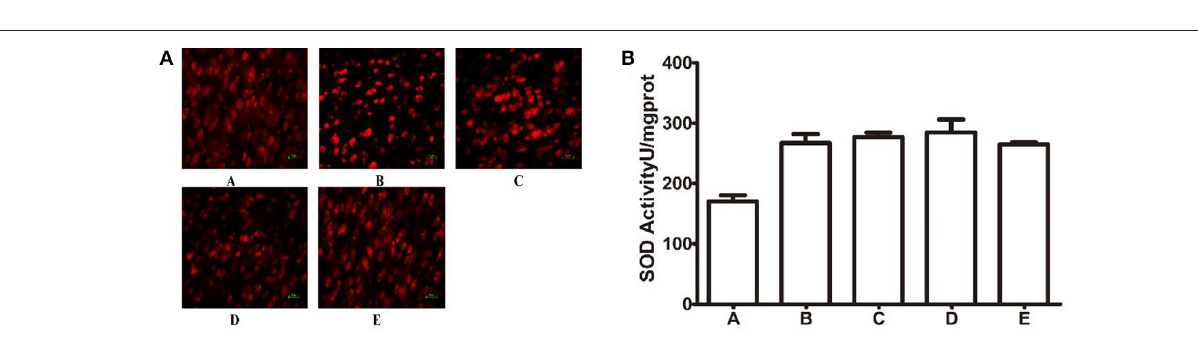
FIGURE 8 | Changes of ROS generation in different groups. (A) ROS Fluorescent Probe-DHE. (B) SOD. A, Normal group; B, GI-R group; C, FN + GI-R + L -Glu group; D, LHA + GI-R + Baclofen group; E, LHA + GI-R + CGP35348 group. n =